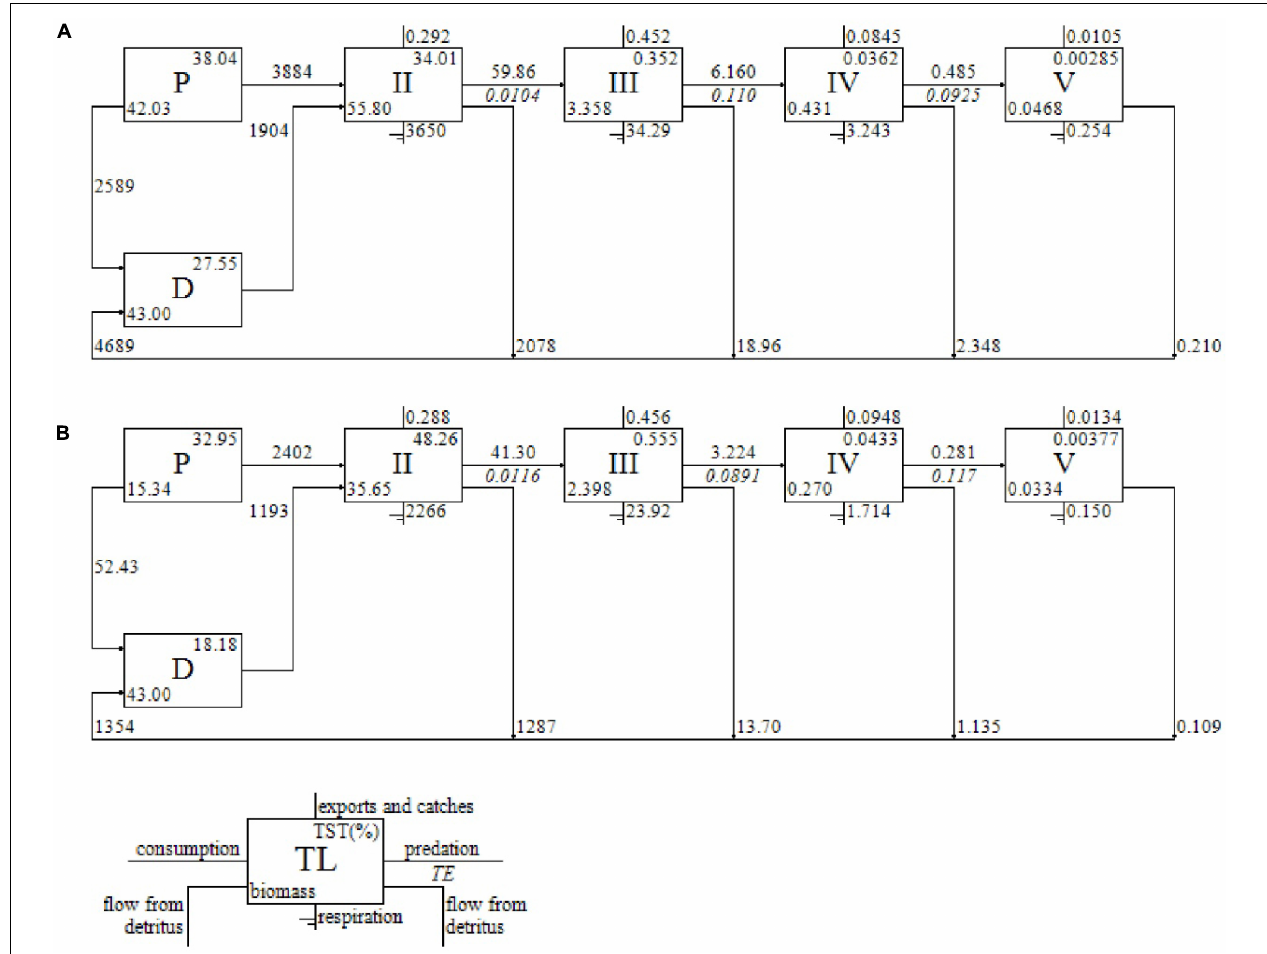
FIGURE 3 | Energy flows of the artificial reef food web in summer (A) and autumn (B) of